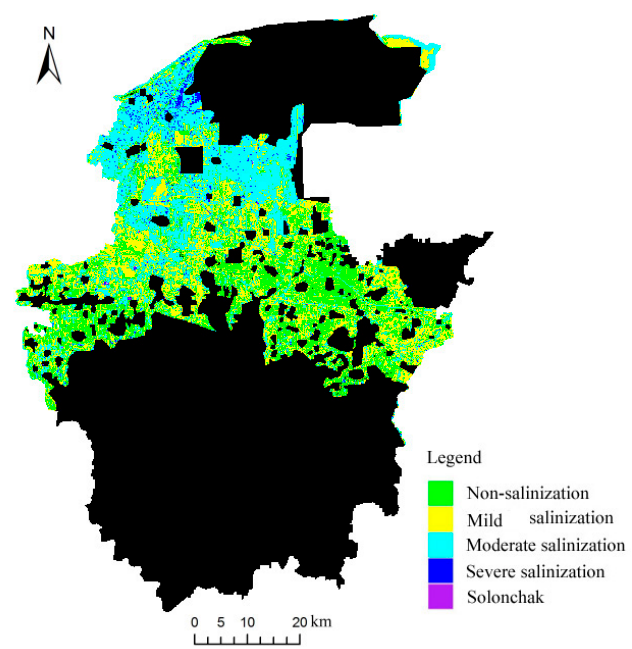
Figure 5. Soil Salinization Distribution of PMS Image in Northern Shouguang in 2017.